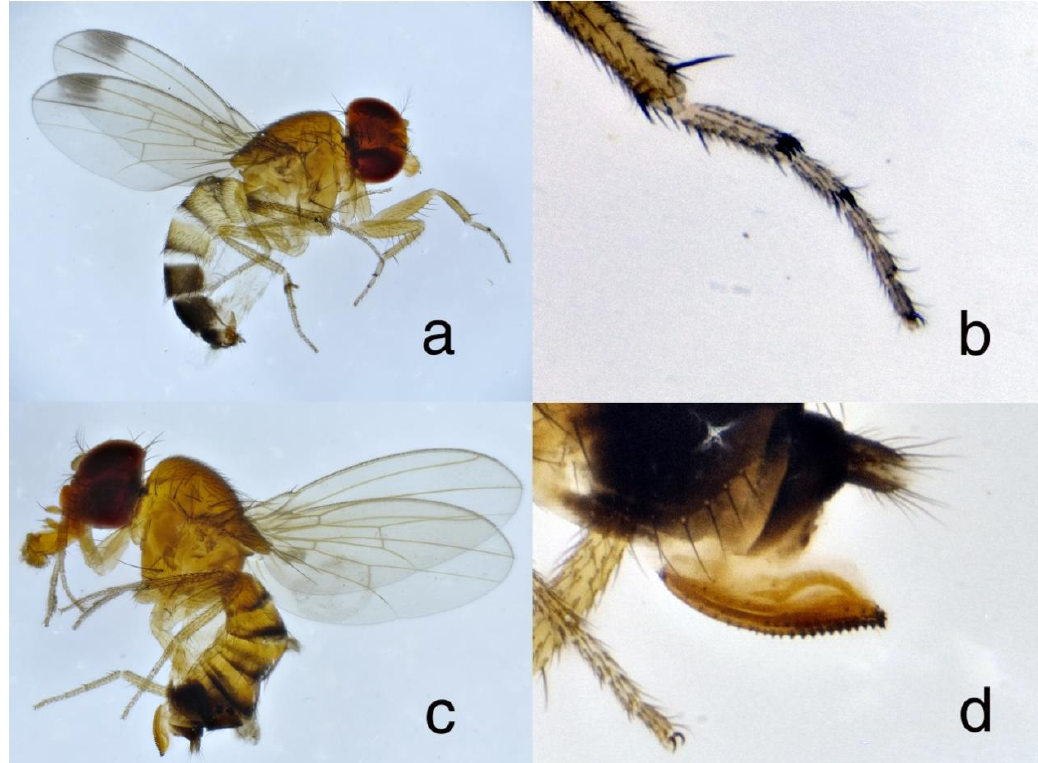
Figure 1. Drosophila suzukii , European Russia, Sochi city. ( a ) Male, total view; ( b ) male, fore tarsus; ( c ) female, total view; ( d ) female, ovipositor.